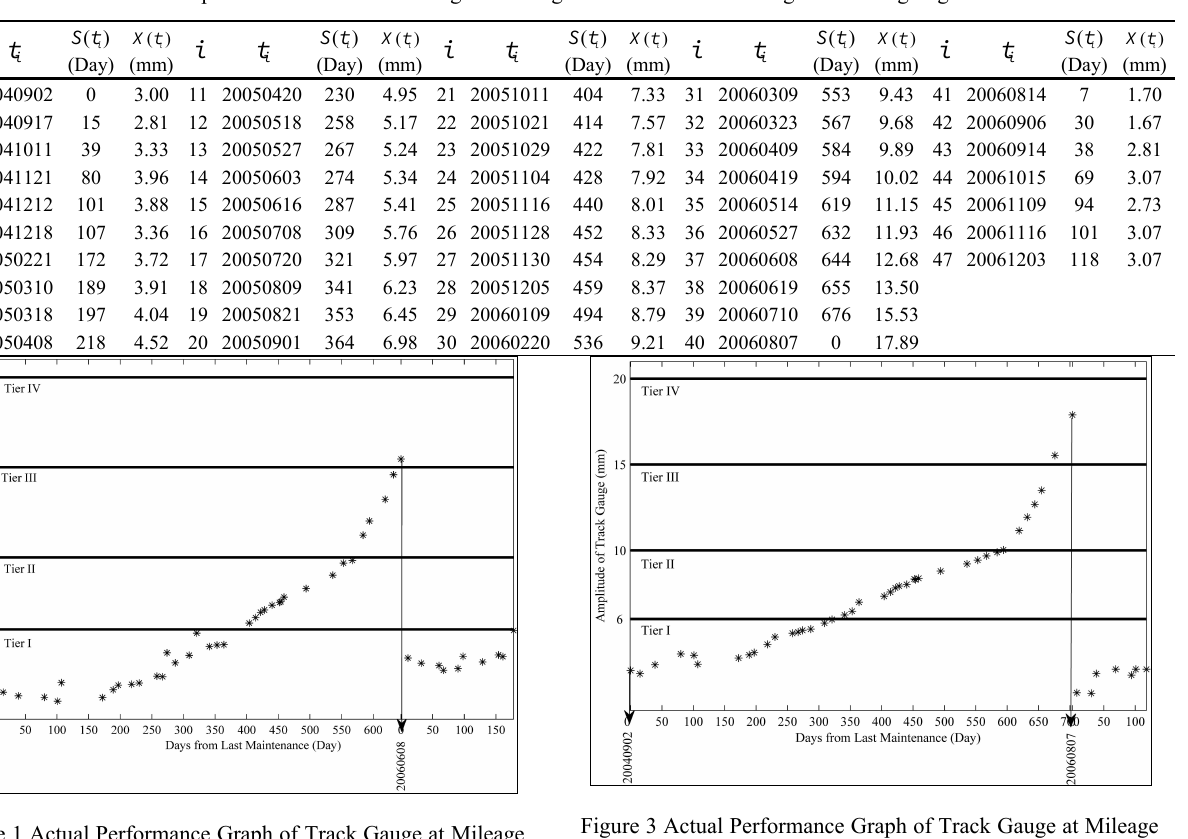
Table 6 Amplitude Series of Track Gauge at Mileage Point K423+606 in Jing-Hu Down-going Track